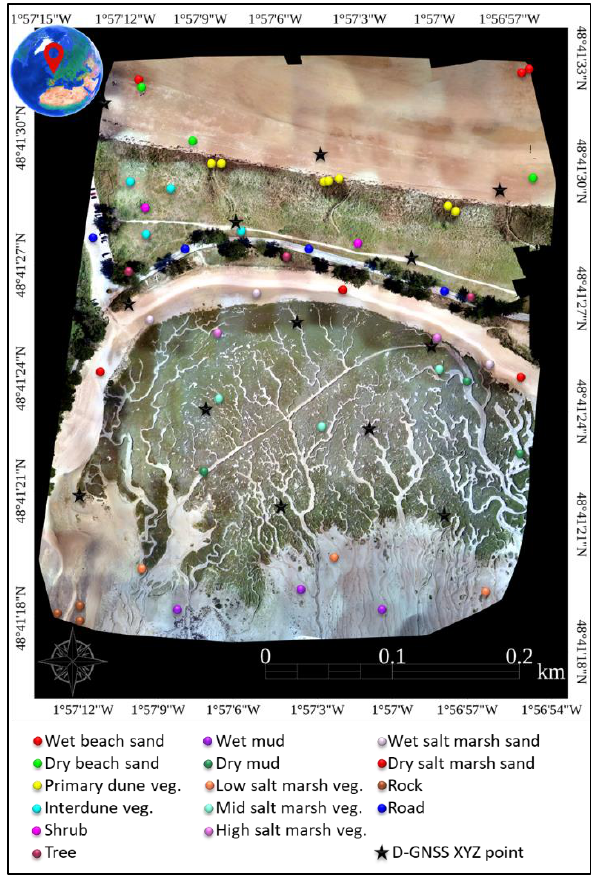
Figure 1 . Natural-coloured orthomosaic (7132 × 8974 pixels) derived from the Phantom 4 Pro V2 RGB sensor, over which geolocations of the 15-classed ground-truth are